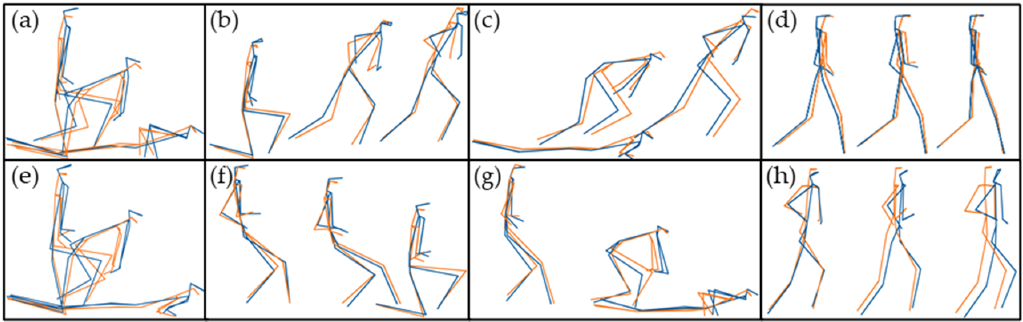
Figure 3. Military Movements. Blue represents an average OPT mover; orange represents